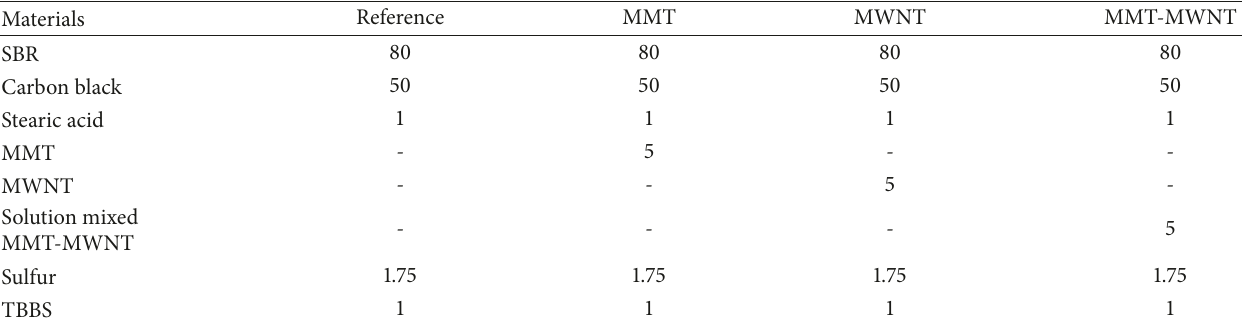
Table 1: Formulation of the elastomer